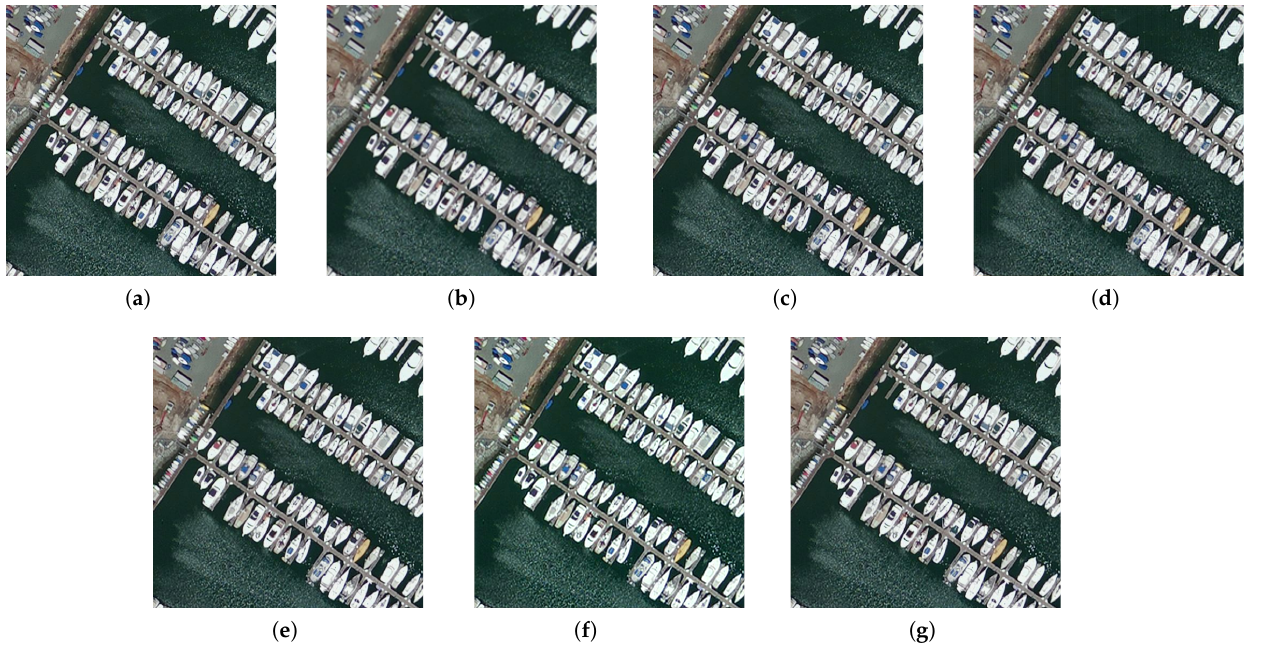
Figure 12. Comparison of visual results of different SR methods with × 2 super-resolution on the RSC11 [44] dataset (port scene). ( a ) HR. ( b ) Bicubic. ( c ) EDSR [68]. ( d ) RCAN [81]. ( e ) RDN [64]. ( f ) SAN [83]. ( g ) NLSN